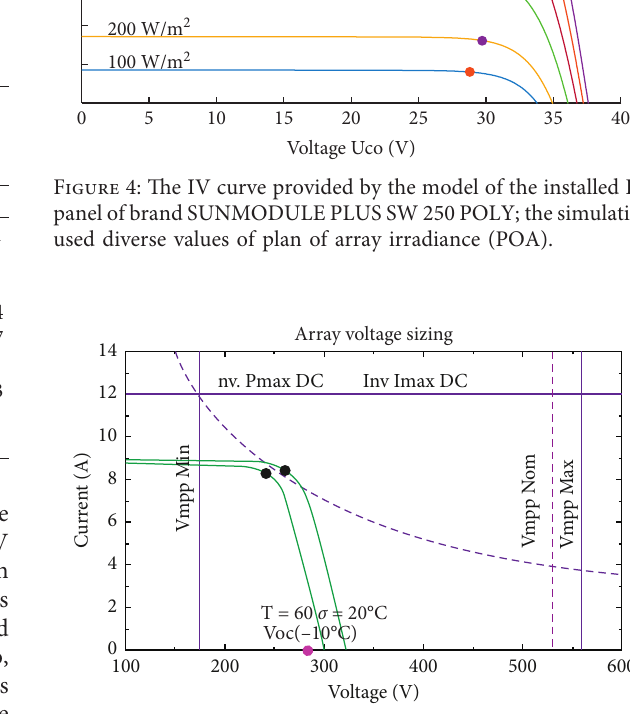
Figure 5: A snapshot view of the PV array at ENSET School. This architecture corresponds to the series configuration of PV modules since the value of array voltage is the total of the voltage of each individual PV